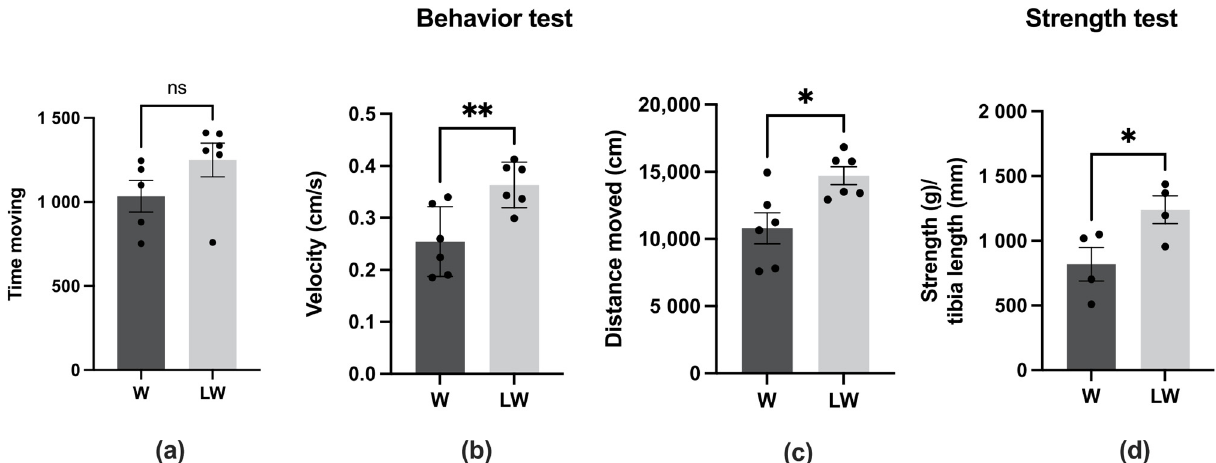
Figure 2. Catwalk functional (Walking test) parameters analyses in tumour-bearing groups, fed or not the leucine-rich diet. ( a ): Maximum contact area (cm 2 ) in forelimb and hindlimb paws; ( b ): Print area (cm 2 ) in forelimb and hindlimb paws; ( c ): Maximum intensity mean in forelimb and hindlimb paws and ( d ): A representative image of 2D walking pattern of both W and LW groups after (endpoint) tumour inoculation. ( N = 3). For details, see the Methods section. RF — right front; LF — left front; RH — right hind; LH — left hind. The average forepaws (RF and LF) was considered forelimb, and the average hind paws (RH and LH) were considered hindlimb. Graphics represent mean ± SEM. * p < 0.05 and ns = not significant by t -test.